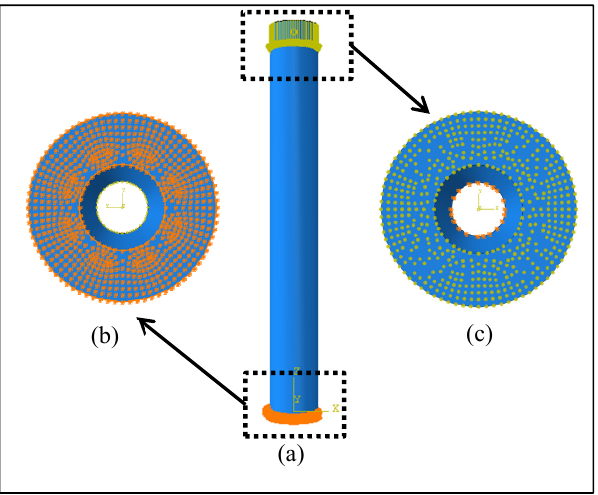
Figure 3. Circular hollow unconfined RC column modeled in ABAQUS FEA; (a) Front view (b) bottom plan view showing support boundary condition (c) Upper plan view showing full axial load imposed on top of the column.